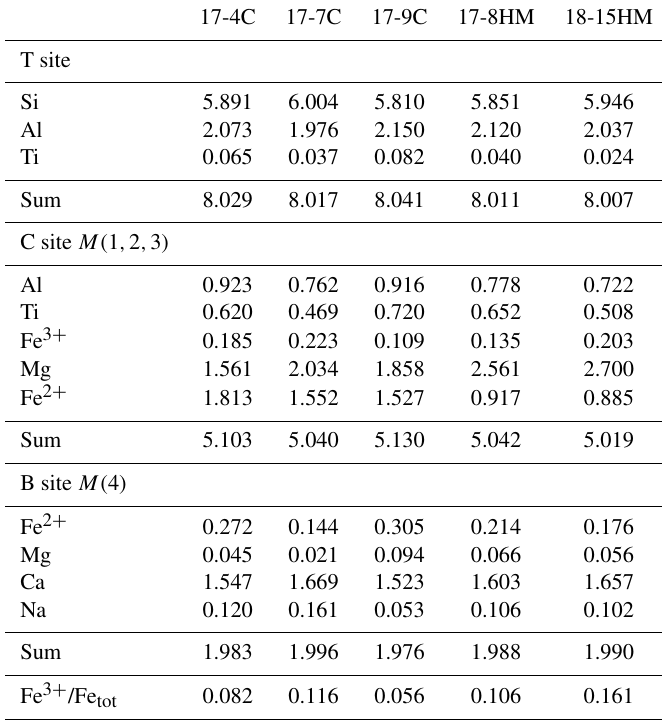
Table 5. Calculated occupation of the amphibole T, B, and C sites and estimated Fe 3 + / Fe tot .